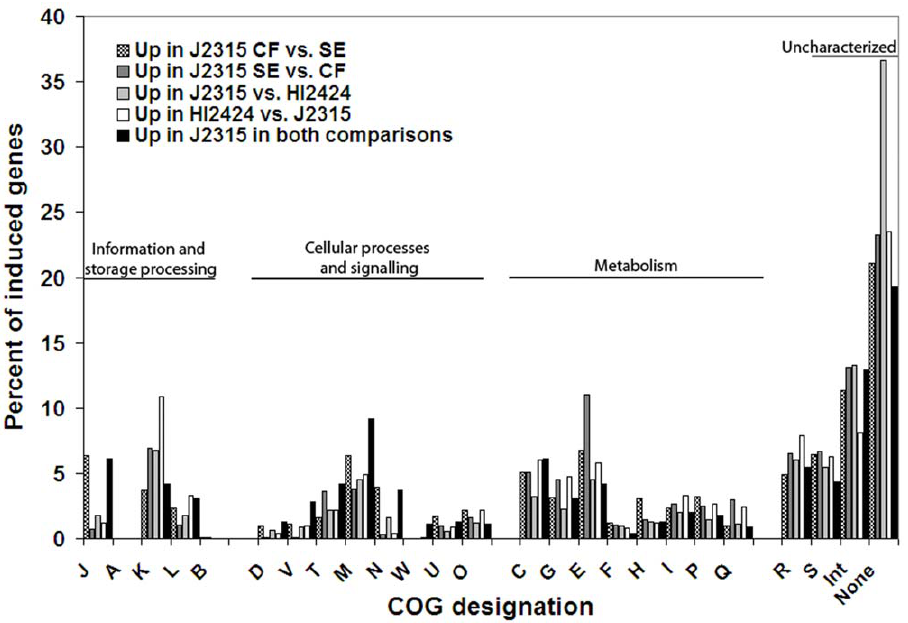
Figure 2. Classification of induced genes by COG functional categories. The percentages of each gene list that encodes proteins belonging to a given COG category are listed for each COG (Table S7 contains key). Checkered bars indicate those genes induced in J2315 under CF conditions in both comparisons (i.e. CF vs. SE conditions, J2315 vs. HI2424 under CF conditions). All raw data are provided in supplementary Tables S2, S3, S4, S5, S6.